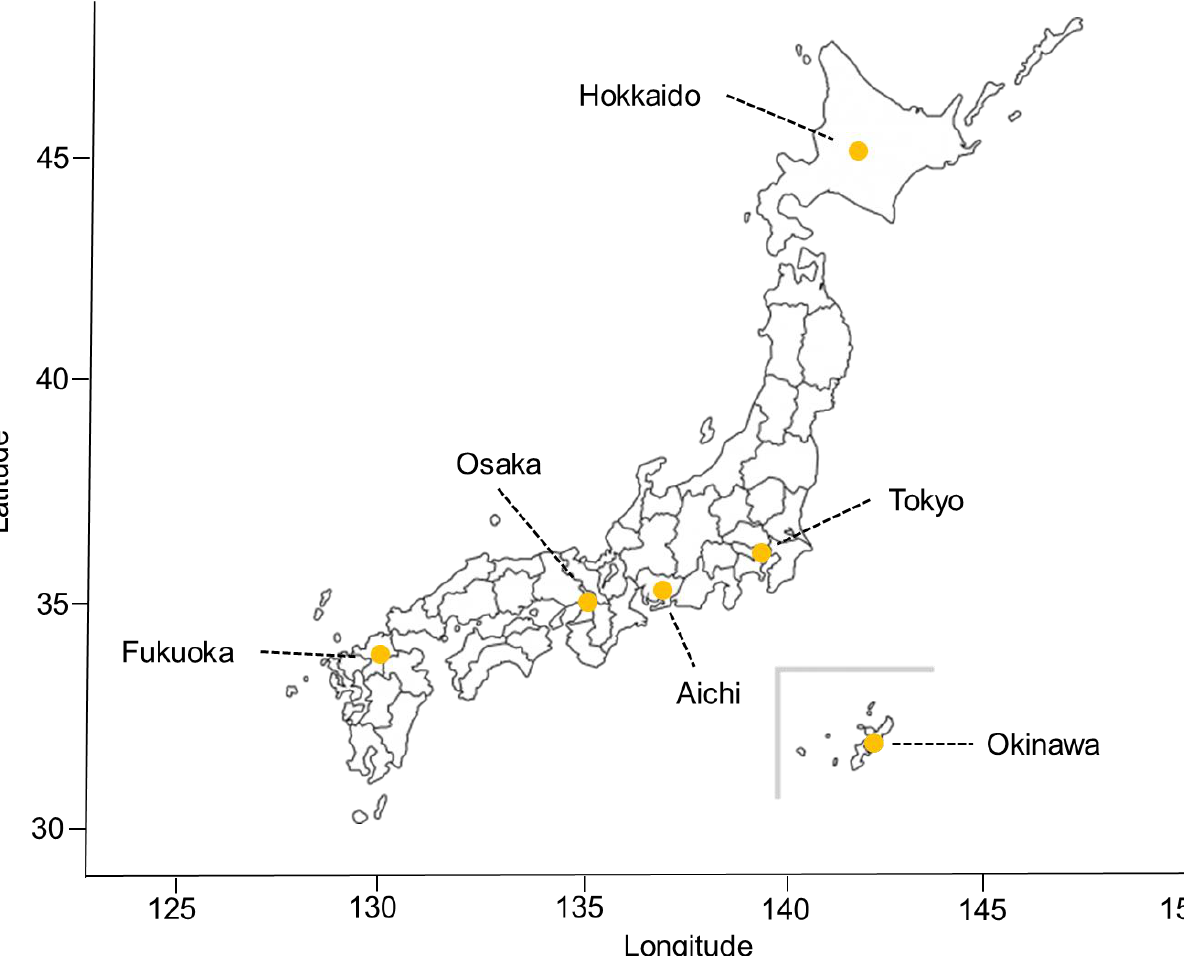
Figure 1. The geographic locations of the six selected Japanese prefectures. Japan is located at latitudes from approximately 26 ◦ N to 43 ◦ N and longitudes from approximately 127 ◦ E to 141 ◦ E in the Western Pacific region and constructed of a total of 47 Japanese prefectures (covering the whole country) from north to south: Hokkaido, Aomori, Iwate, Miyagi, Akita, Yamagata, Fukushima, Ibaraki, Tochigi, Gunma, Saitama, Chiba, Tokyo, Kanagawa, Niigata, Toyama, Ishikawa, Fukui, Yamanashi, Nagano, Gifu, Shizuoka, Aichi, Mie, Shiga, Kyoto, Osaka, Hyogo, Nara, Wakayama, Tottori, Shimane, Okayama, Hiroshima, Yamaguchi, Tokushima, Kagawa, Ehime, Kochi, Fukuoka, Saga, Nagasaki, Kumamoto, Oita, Miyazaki, Kagoshima, and Okinawa (Figure S1). The orange dots indicate the geographical locations studied in selected six Japanese prefectures (i.e., Tokyo, Osaka, Aichi, Hokkaido, Fukuoka, and